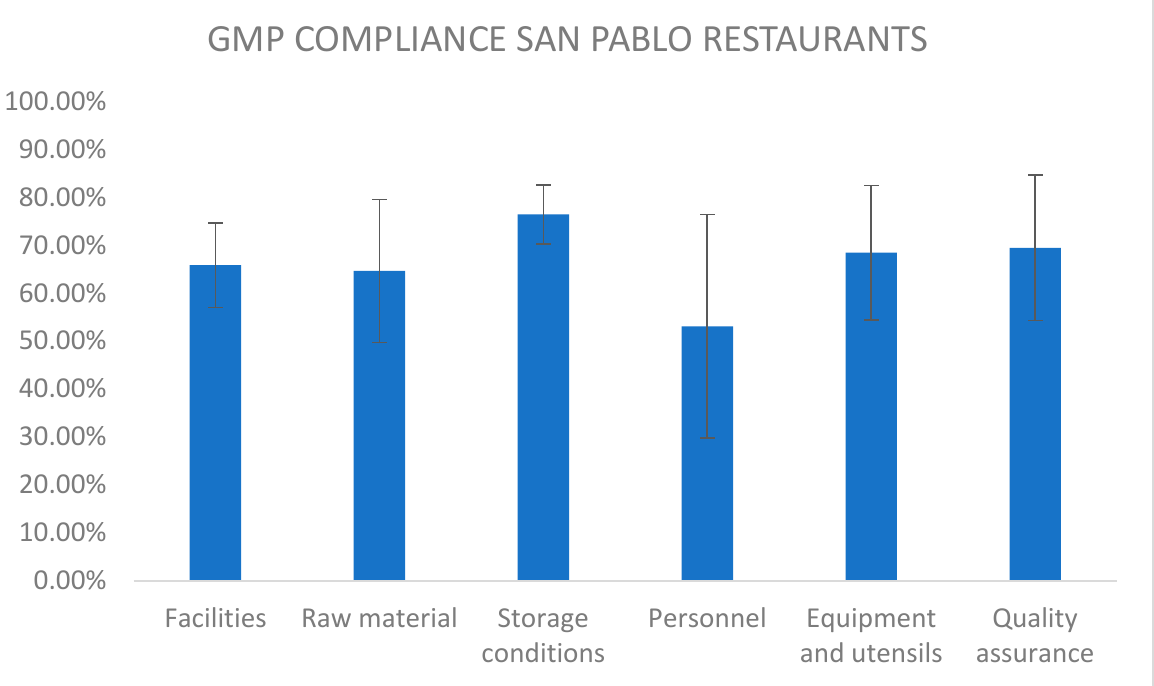
Figure 1. GMP compliance of San Pablo restaurants.